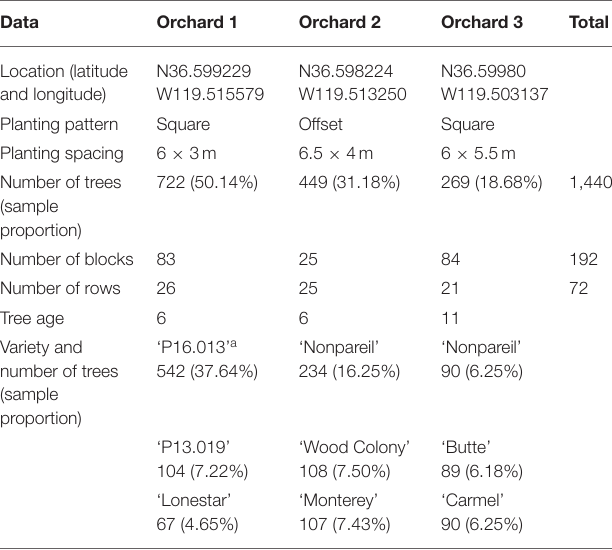
TABLE 1 | Details of the experimental orchards used in this